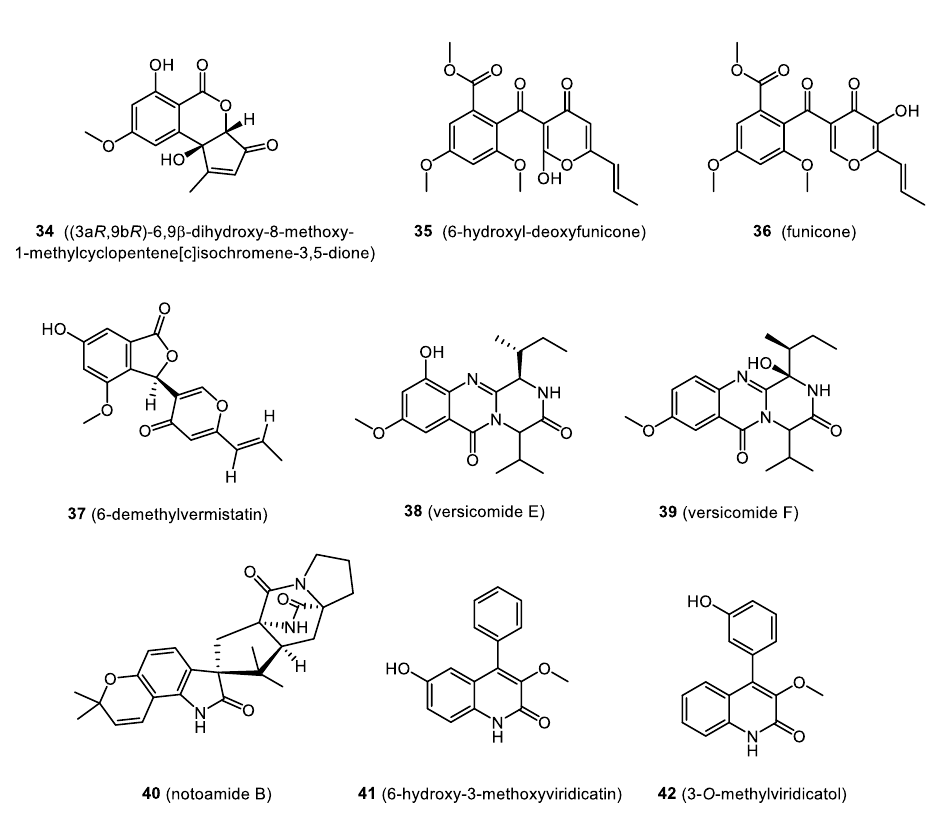
Figure 7. Bryendophyte metabolites ( 34 – 42 ) with allelopathic and anti-inflammatory activities.